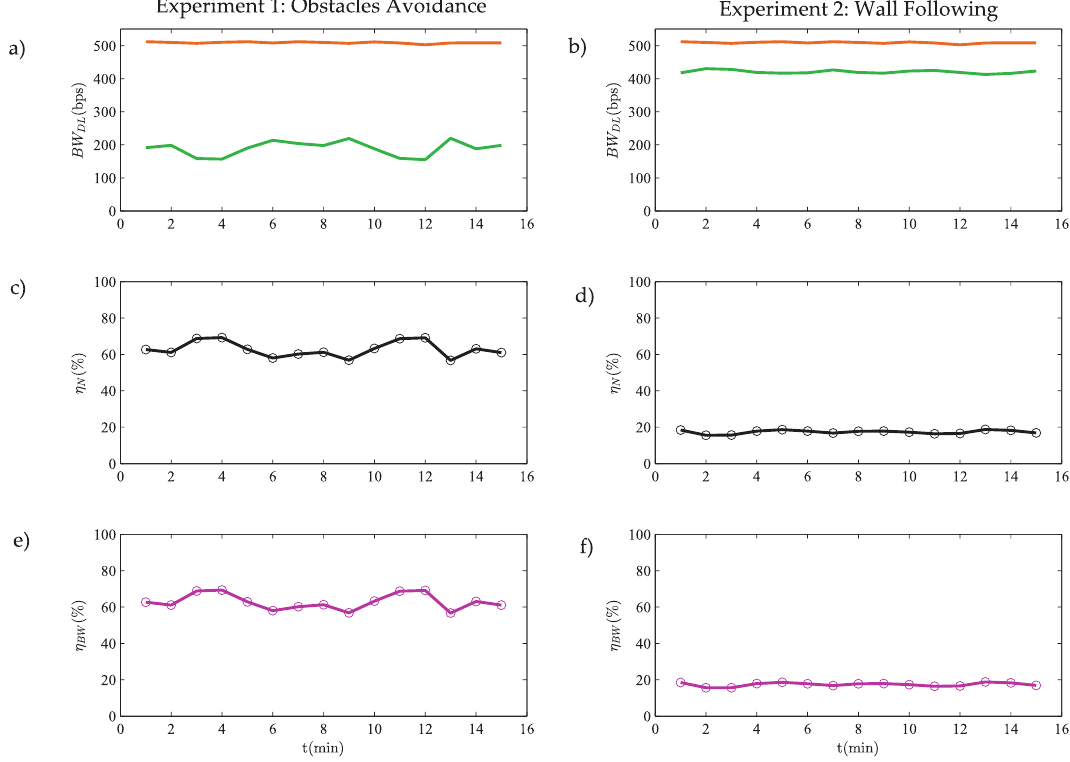
Figure 15. Bandwidth efficiency: ( a , b ) download bandwidth, where orange line represents the discrete-time architecture and the green line the event-based architecture; ( c , d ) event efficiency η N ; and ( e , f ) download bandwidth efficiency η BW